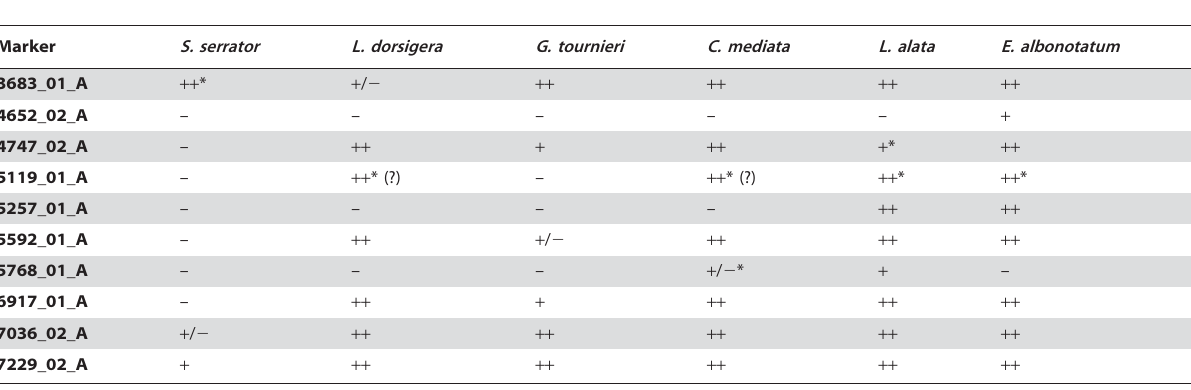
Table 4. Rating of obtained polymerase chain reaction (PCR) products.